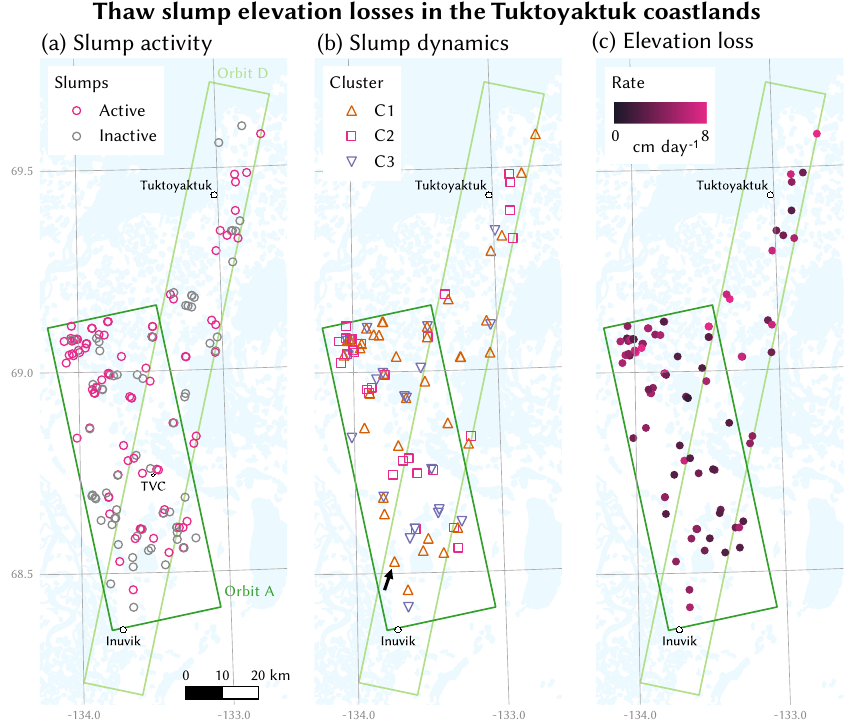
Figure 3. Overview of the study area and all mapped thaw slumps. (a) Slumps in the TanDEM-X data according to whether activity could be detected. The locations of in situ measurements at Inuvik and Trail Valley Creek (TVC) are also shown. (b) The sub-seasonal dynamics from mid-July to late August form three clusters. The arrow denotes the slump 152 shown in Fig. 4. (c) Variability of the seasonal elevation loss rate r s from mid-July to late